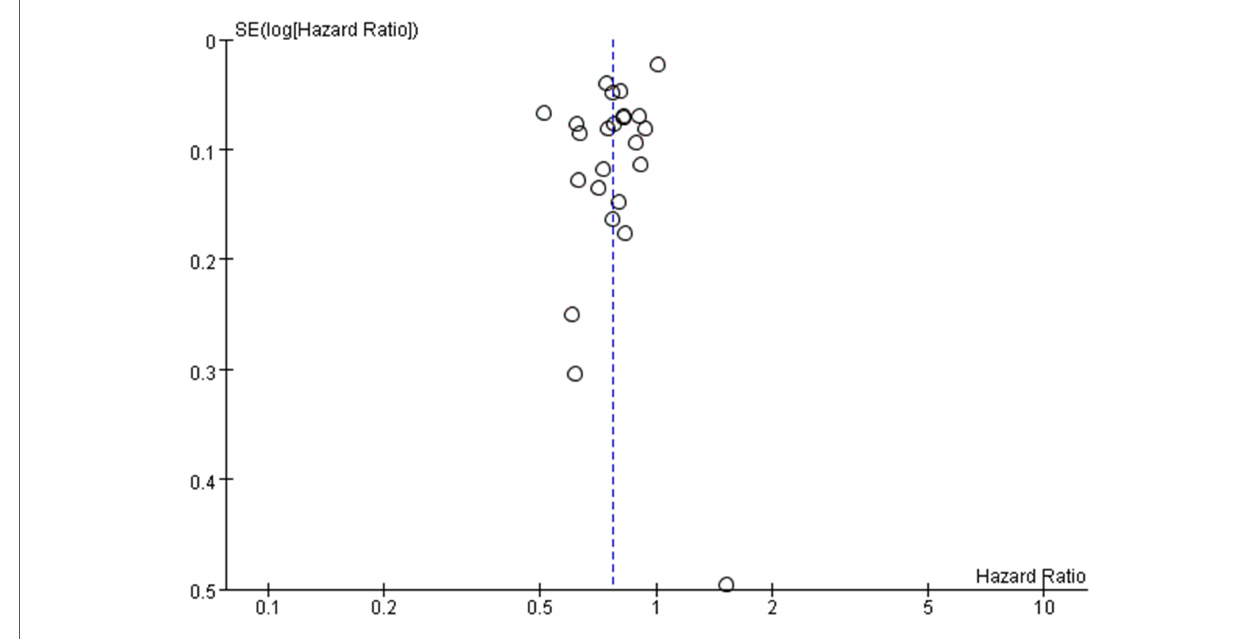
FIGURE 3 Funnel plot of survival bene fi t following esophagectomy comparing high- with low-volume hospital